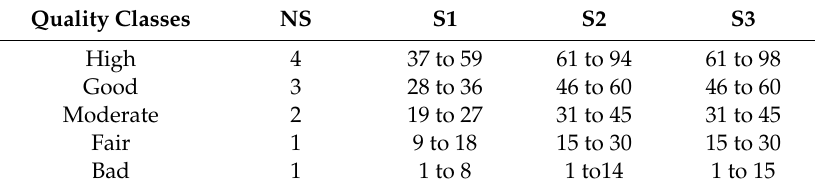
Table 2. Score limits of the ecological quality classes for each tested